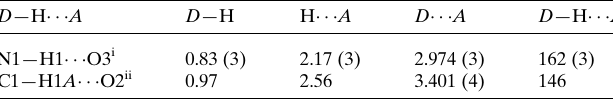
Table 1 Hydrogen-bond geometry (A˚ , (cid:4) ).